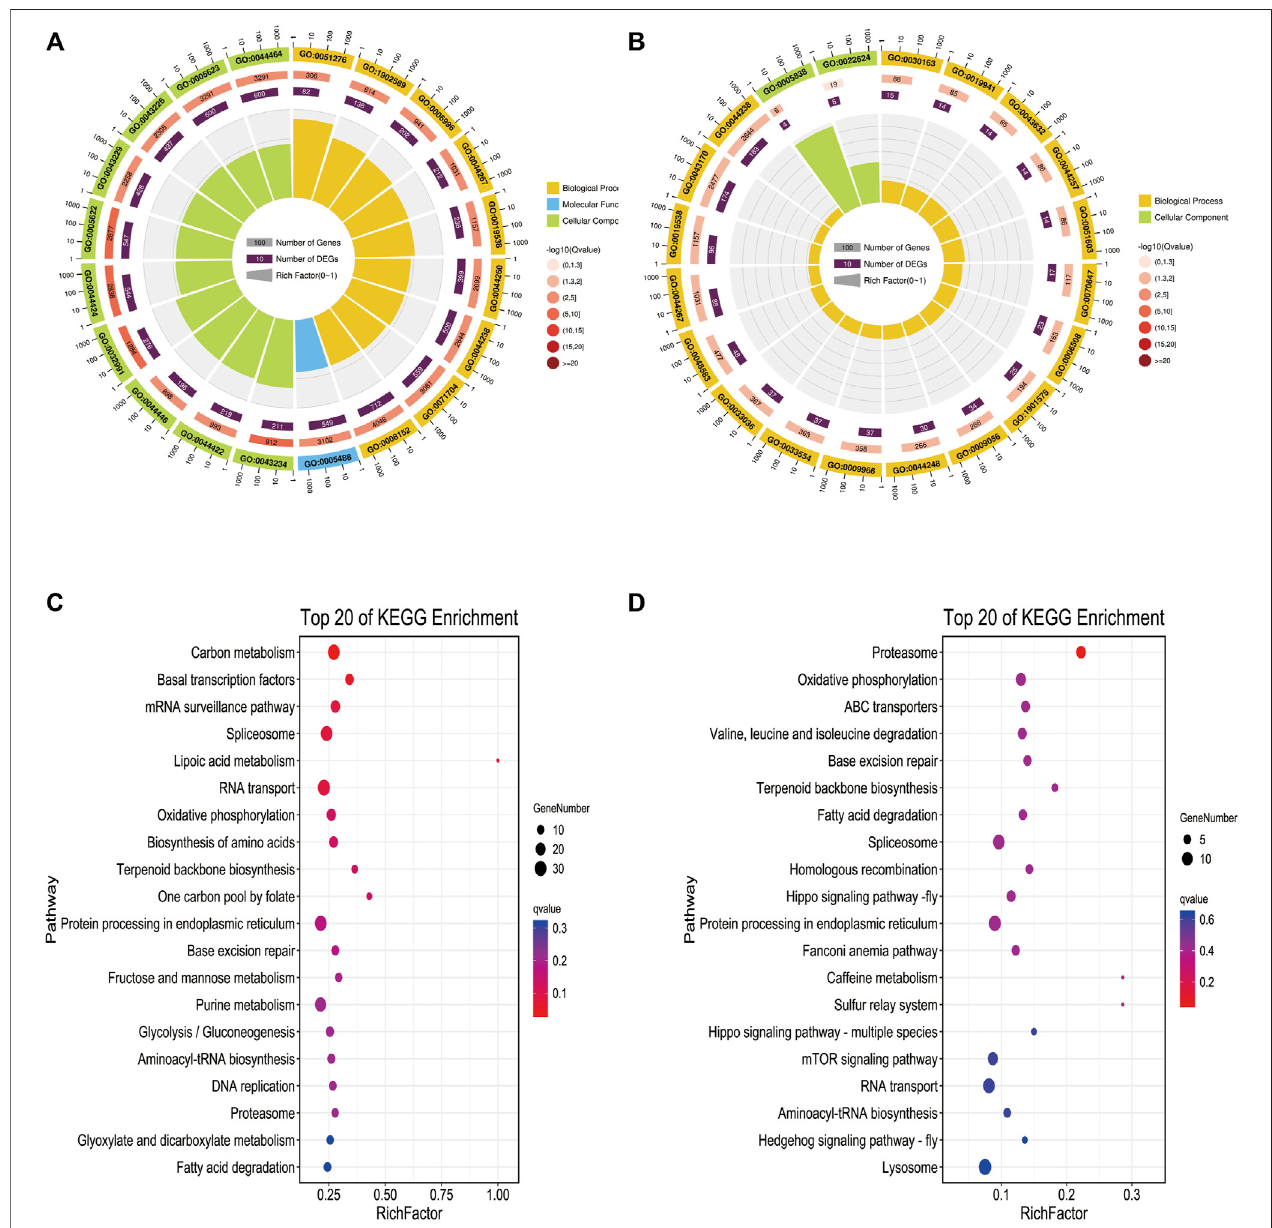
FIGURE4| GOandKEGGfunctionenrichinDMR-relatedgenes. (A) Statisticsofthetop20GOtermsenrichedforDMGsinYMPvs.WMP; (B) statisticsofthetop 20 GO terms enriched for DMGs in YMP vs. YMC; (C) statistics of the top 20 pathways enriched for DMGs in YMP vs. WMP; (D) statistics of the top 20 pathways enriched for DMGs in YMP vs.